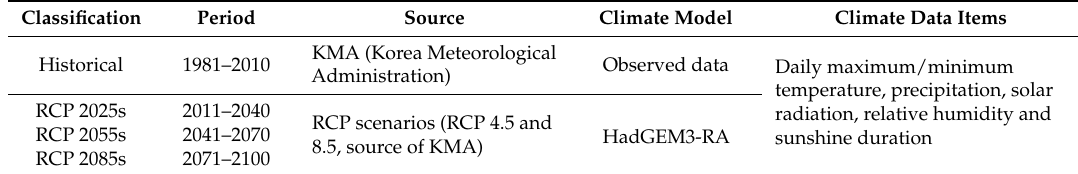
Table 2. Classification of climate change data from Representative Concentration Pathways (RCPs) scenarios.